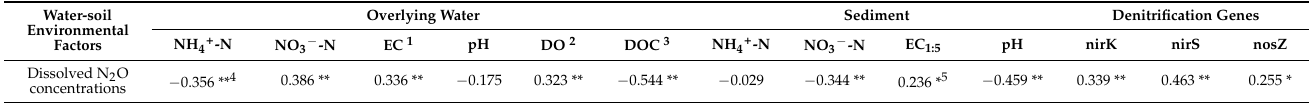
Table 1. Correlation between dissolved N 2 O concentrations and its influencing